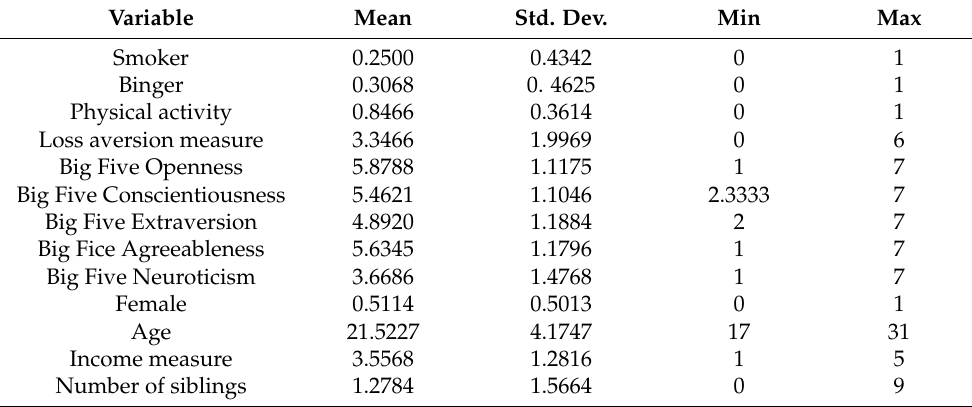
Table 3. Summary statistics, US